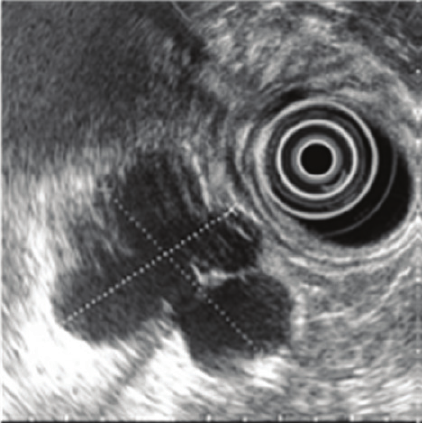
Figure 1: Endoscopic ultrasound image showing the cyst in pan- creatic body.